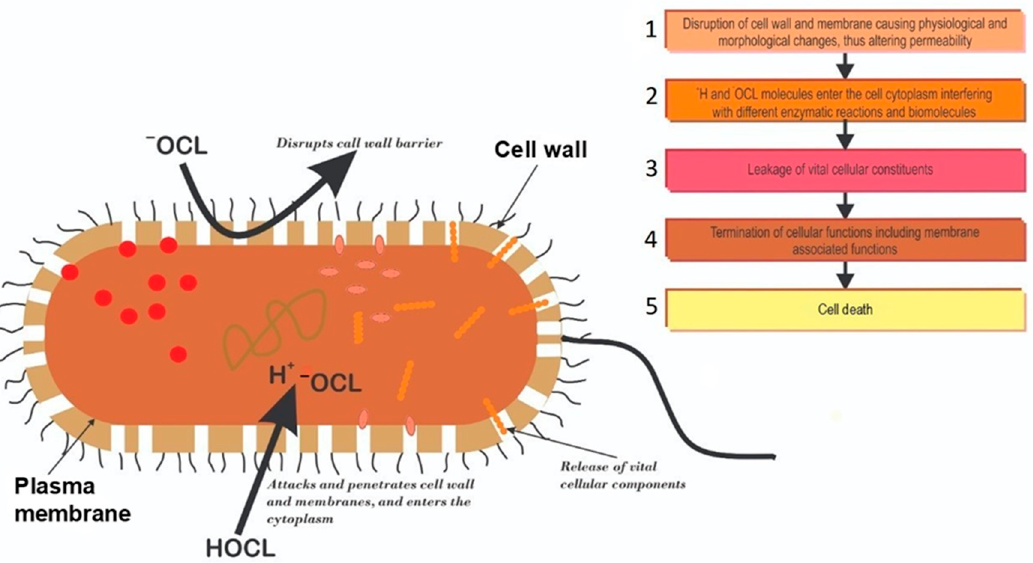
Figure 3. Schematic presentation of the possible events cascade of chlorine disinfection leading to microbial cell death. 1: Dissociating chlorine molecules attack and destroy bacterial cell walls altering permeability; 2: Entry of chlorine molecules into the cytoplasm interfering with biomolecules and enzymatic reactions; 3: Altered permeability causes vital cellular components leakage; 4: The series of events lead to the loss of cellular constituents and functions; 5: The loss of cellular constituents and function lead to eventual cell death.